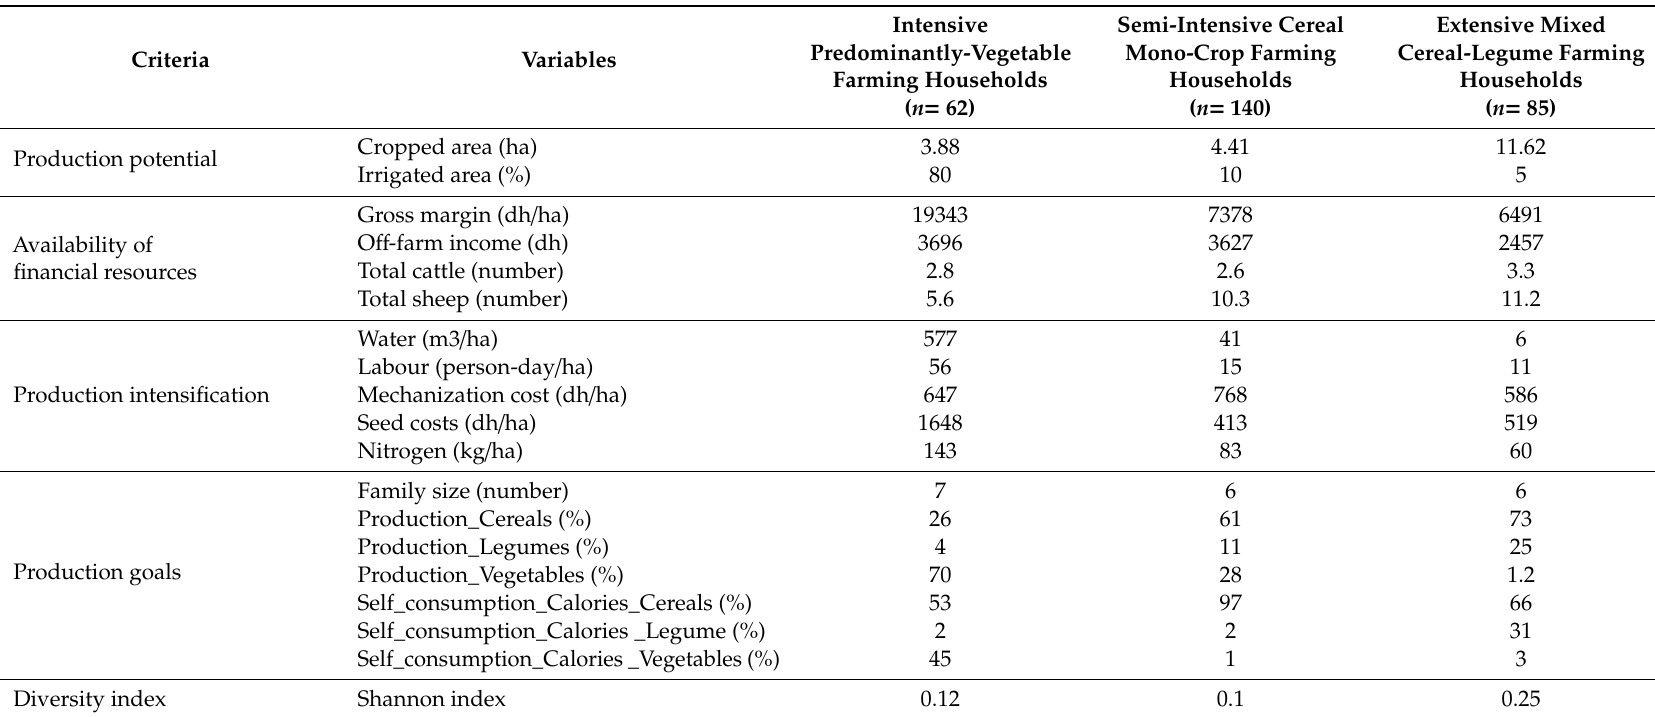
Table 4. Average characteristics of the three farm household types. “ n ” represents the number of farms per farm